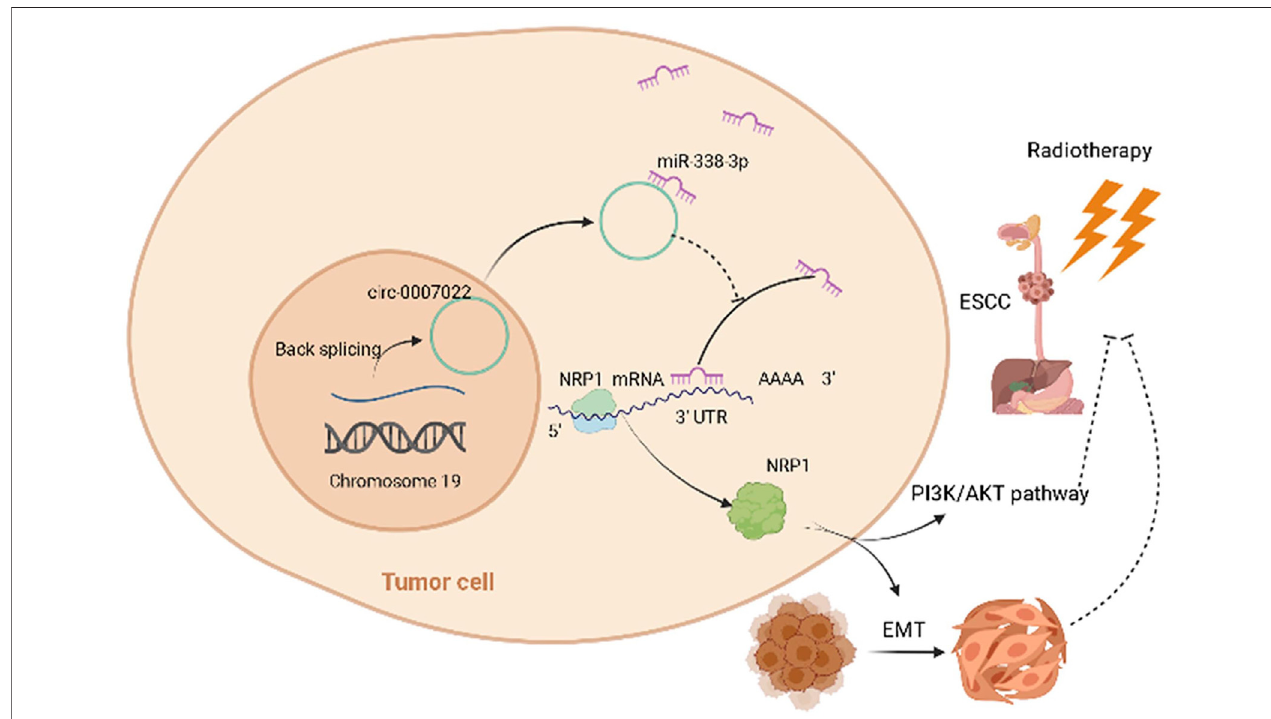
FIGURE 6| Schematic ofthe mechanisms of circ-0007022 in the regulation of radiotherapy resistance in ESCC. Circ-0007022/miR-338-3p/NRP1 axis promotes ESCC radiotherapy-resistance by activating EMT and PI3K/AKT pathway.